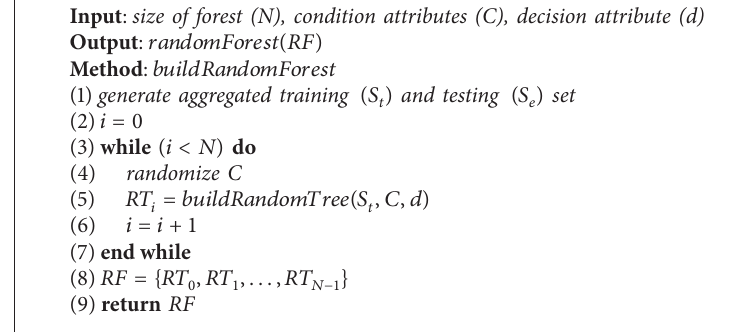
Algorithm 2: Random forest.